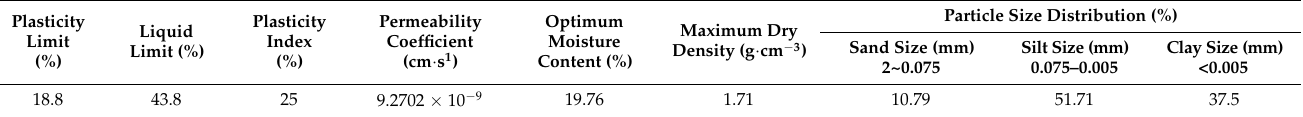
Table 1. Basic physical properties of red